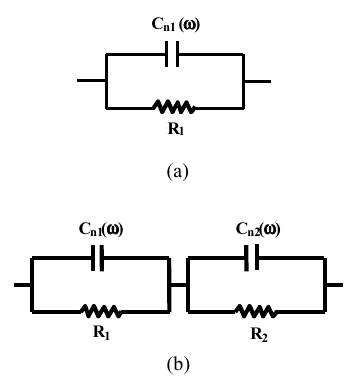
Figure 12. Equivalent circuits used for fitting the experimental data. The circuit in (a) was used when only high frequency semicircle was present and that in (b) was used where the low frequency spur co-exists with the high frequency